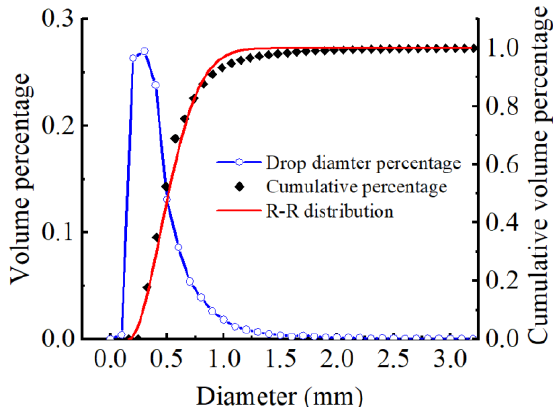
Figure 6. Distribution characteristics of droplet diameter (Square nozzle with 200 kPa).